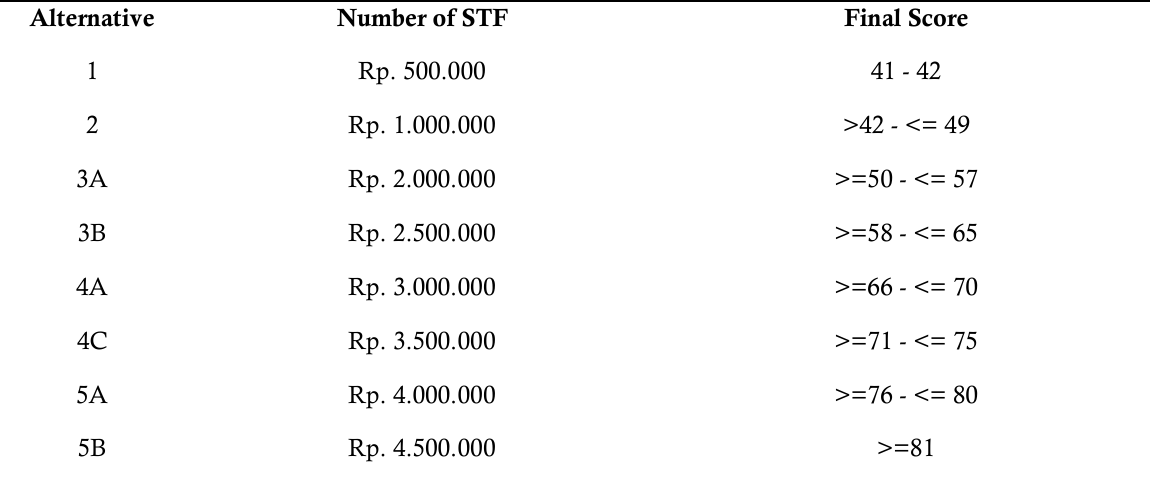
Table 1. Alternative Prospective STF